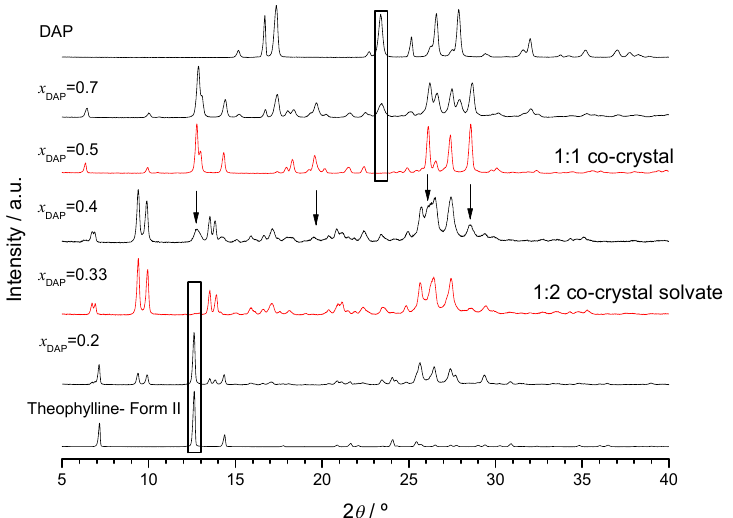
Figure 5. X-ray powder diffractograms of representative DAP + THEO mixtures prepared by ethanol-assisted grinding.